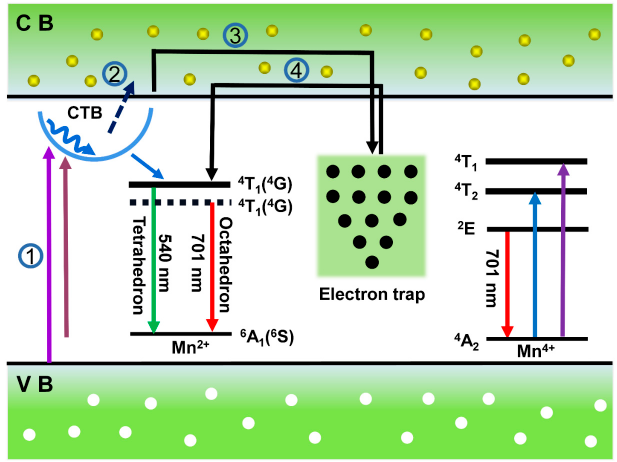
Figure 7. The proposed PL, PersL and PSL schematic diagram for green and red luminescence of Mn 2+ /Mn 4+ in the Zn 3 Ga 2 GeO 8 phosphors. Therein, ① UV light excitation, ② energy (or electron) transfer processes, ③ trapping, ④ release. The straight-line arrows and curved-line arrows stand for optical transitions and energy (or electron) transfer processes, respectively. Note that the solid and dashed lines represent the 4 T 1 energy levels of Mn 2+ in the weak tetrahedral crystal field and strong octahedral crystal field,